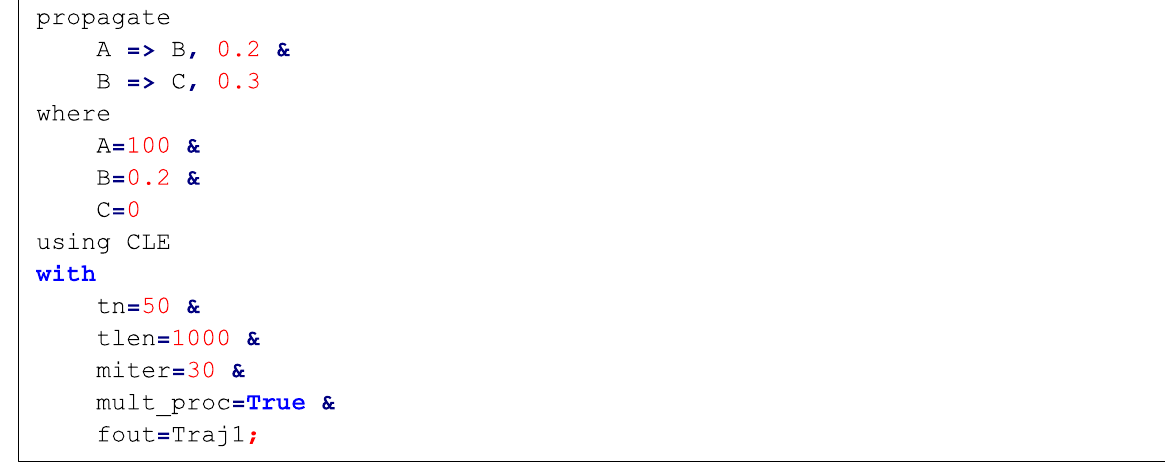
Fig 4. An example of BioSANS structured simulation language (SSL)